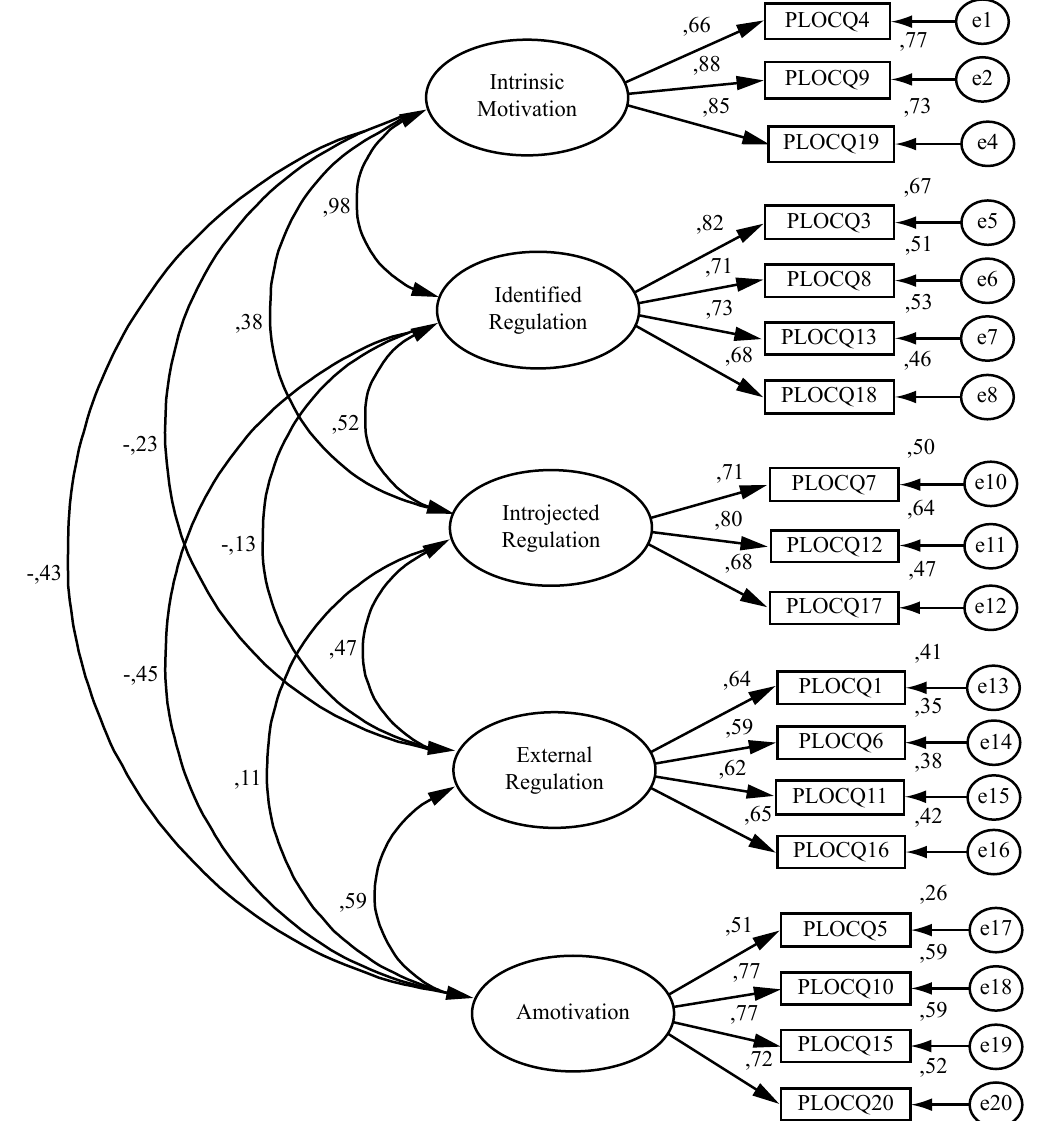
Figure 1 Standardized individual parameters (covariance factors, factorial weights and measurement errors), all of which were signiicant in the measurement model (PLOCQp - Five factors/18 items) for the Portuguese calibration sample